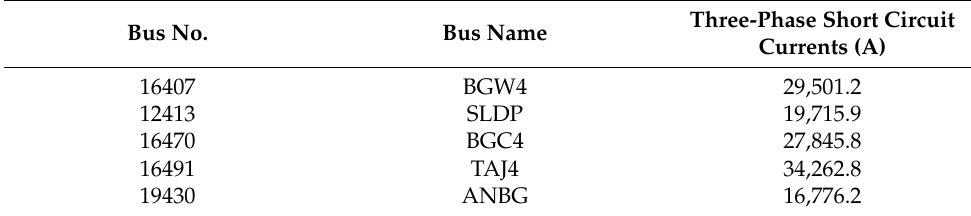
Table 3. Three phase short-circuit levels.